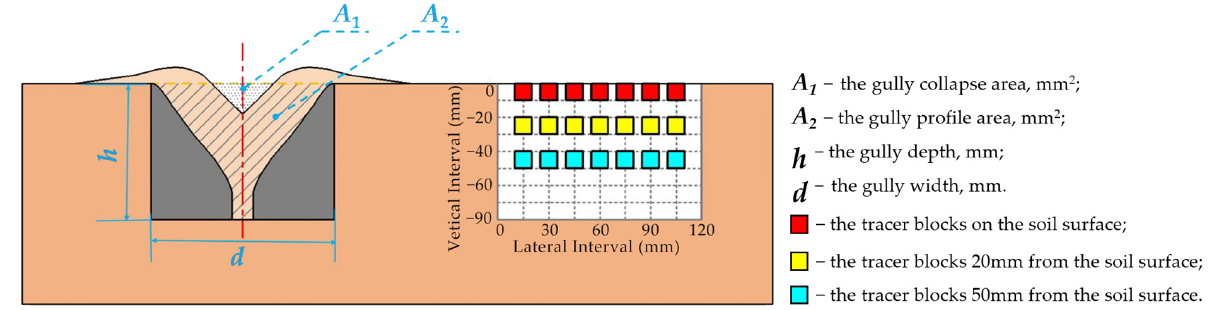
Figure 5. Schematic diagram of the soil disturbance rate and layout of the soil tracer blocks.